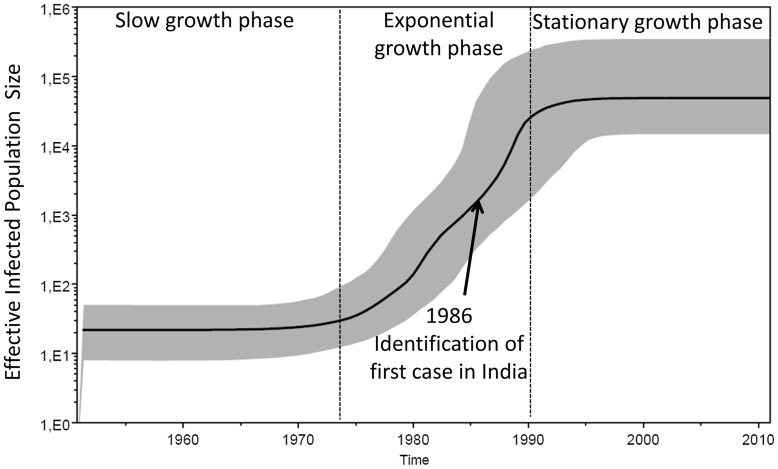
Bayesian skyline plot representing estimates of the effective number of infections through time.The demographic history from the pol BSP identified three epidemic growth phases divided by the vertical lines; an initial slow growth followed by an exponential phase which slowed down to a stationary phase around 1990. The identification of first HIV case in India is indicated by an arrow.